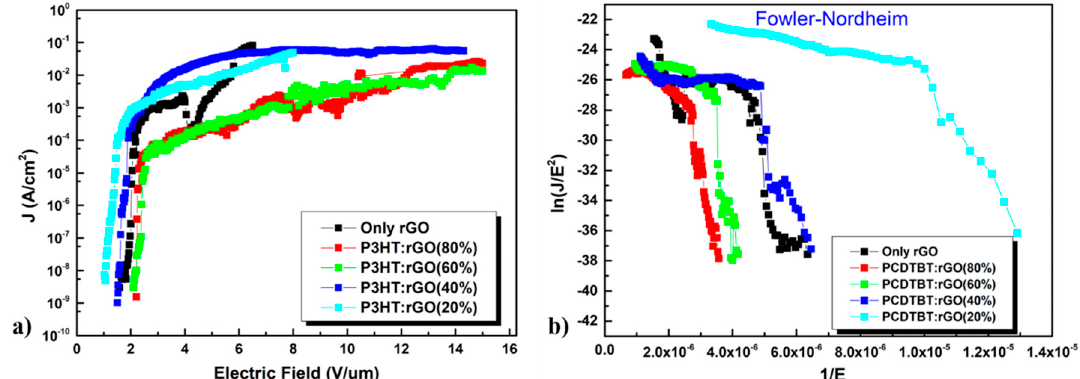
Figure 5. ( a ) Logarithmic plot of the current density, measured as a function of the electric field E ( J – E ), obtained by different concentration ratios of rGO ink in composite n + -Si/P3HT:rGO field emitters. Lowest electrical field threshold appears for the P3HT:rGO(20%) case. ( b ) Fowler–Nordheim curves of the J–E plots of FE with different concentration ratios of rGO ink in composites n + -Si/PCDTBT:rGO.